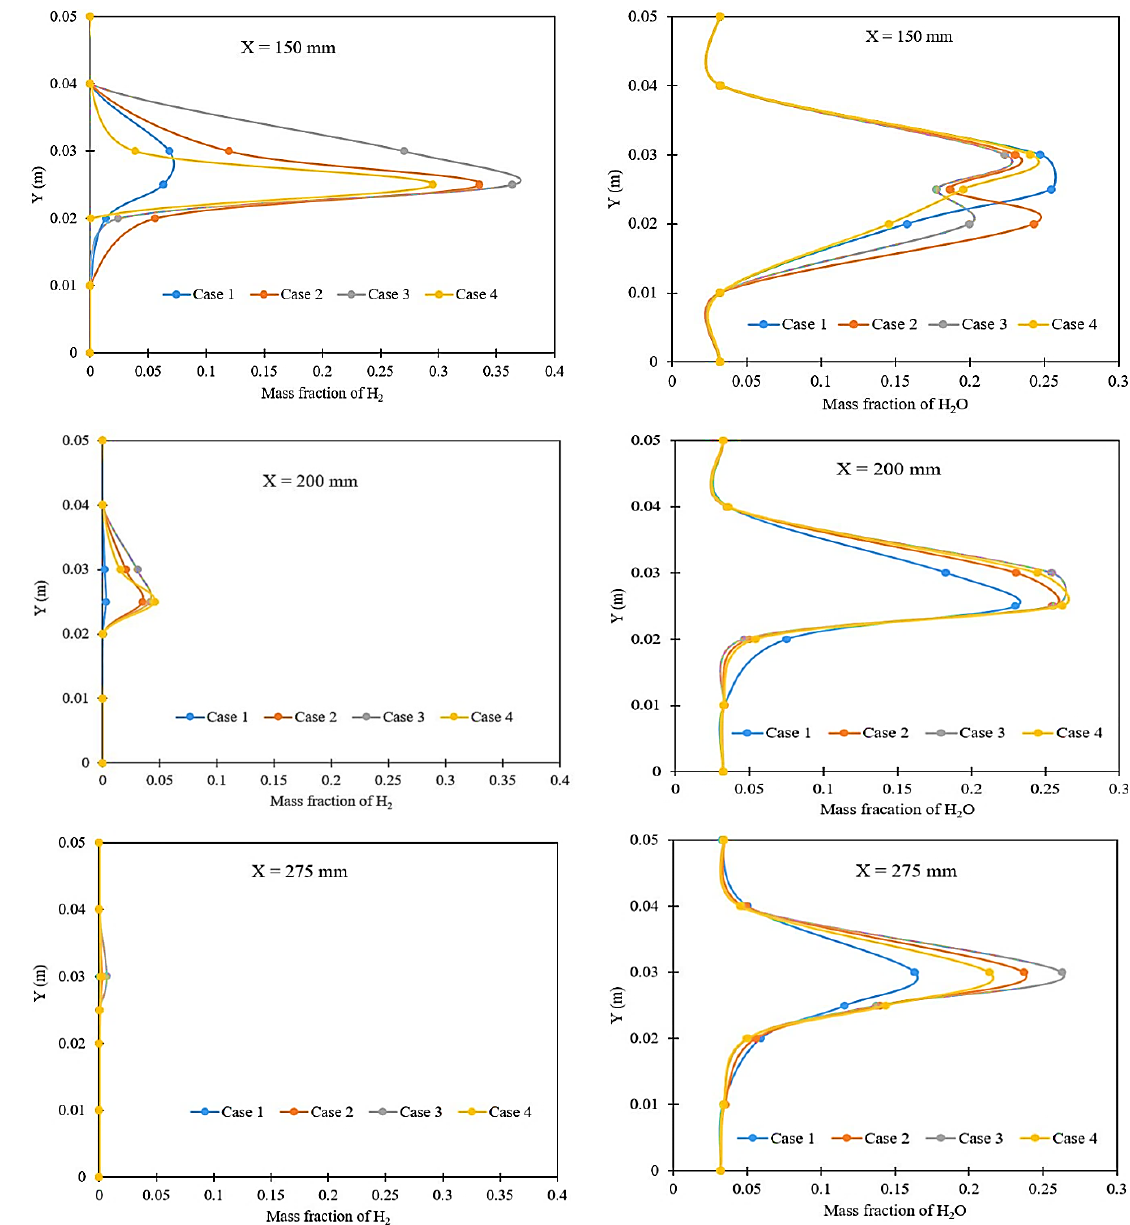
Figure 10. Mass fraction of hydrogen and H 2 O profiles at X = 150 mm, X = 200 mm and X = 275 mm.